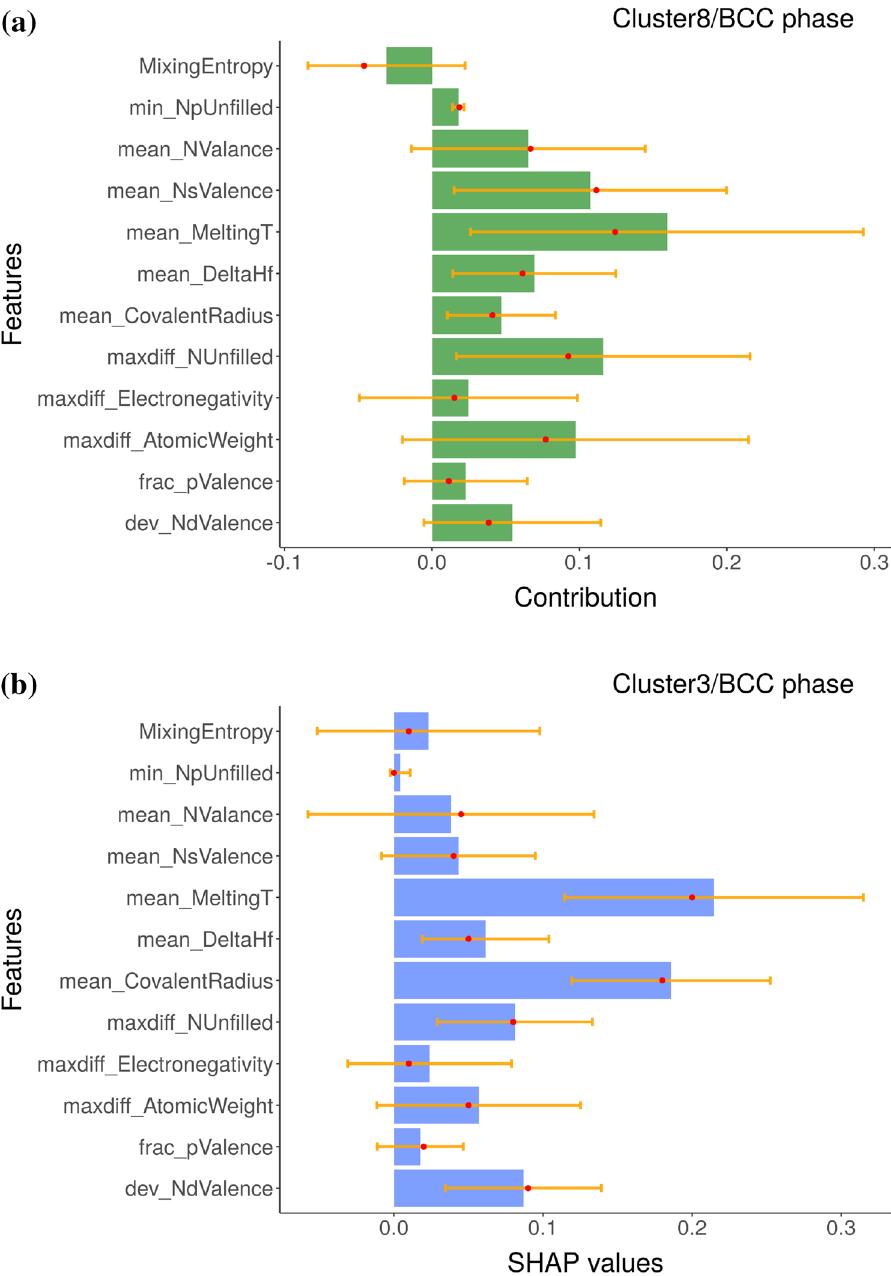
Figure 4. The ( a ) BD and ( b ) SHAP decomposition are plotted for the representative clusters (clusters 8 and 3, respectively), which are predicted to form in the BCC phase by the eSVM model. The size of each bar indicate the averaged contribution of the respective variable towards the overall prediction for a given instance. Red dots and yellow lines denote median values and error bars, respectively. The y-axis of SHAP plot are sorted in the same way as those of BD plot to facilitate the comparison of two